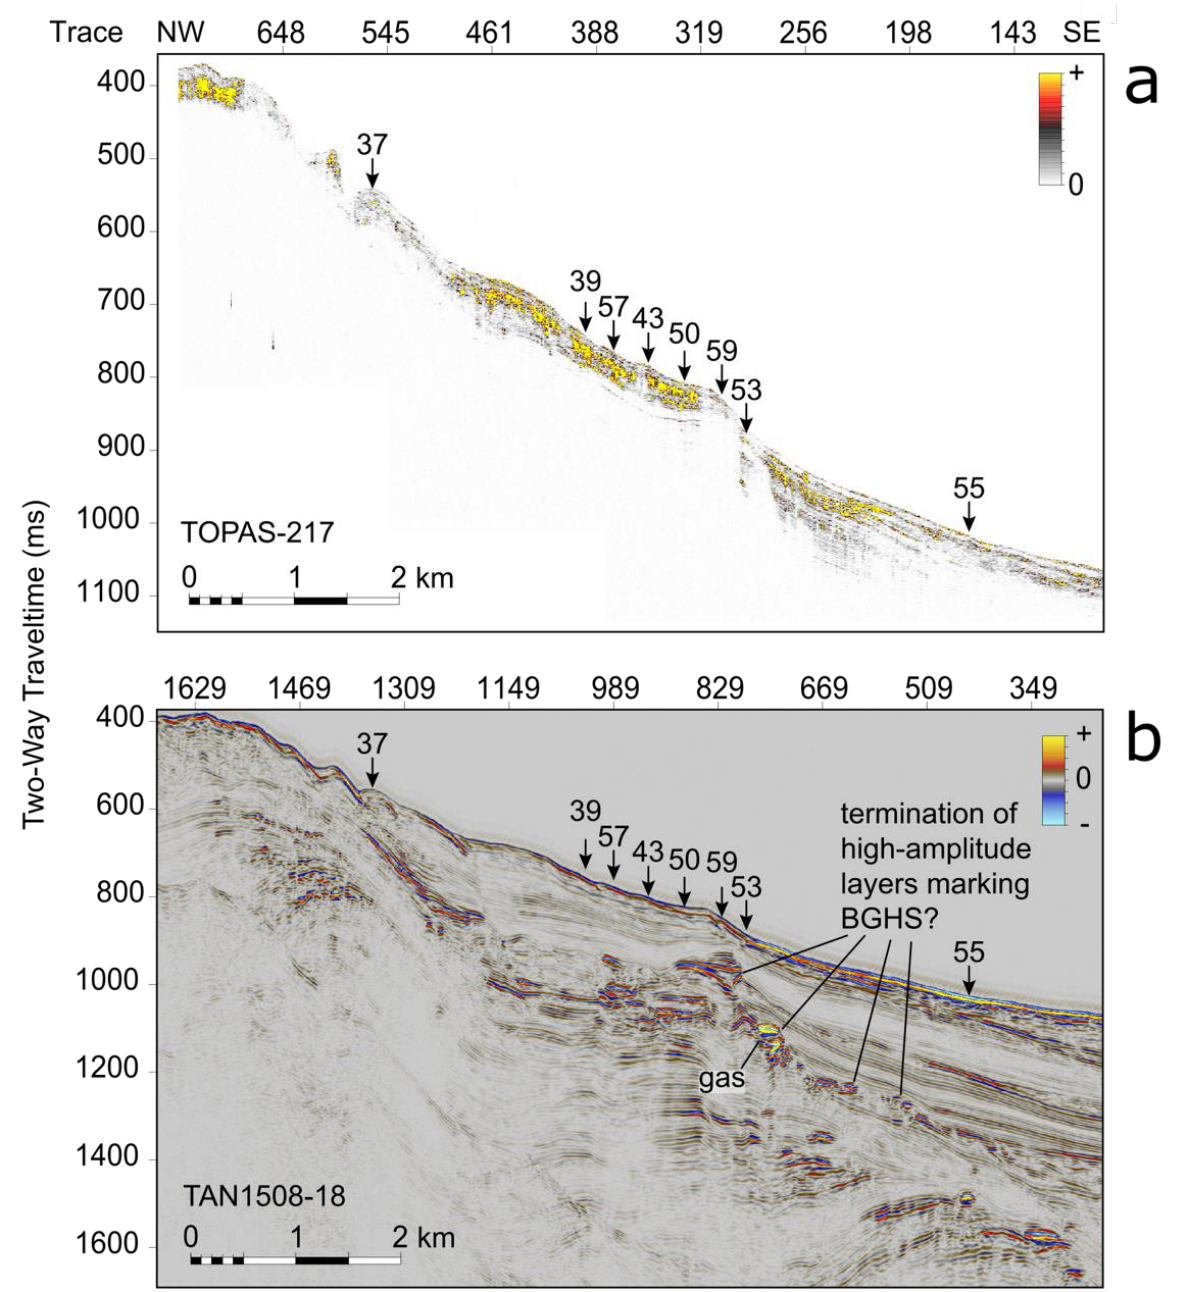
Figure 6. ( a ) TOPAS data from Mahia Transect 2; see Figure 1b for geographical location. Numbered black arrows are piston core sites. ( b ) Seismic data from the same location as the TOPAS data in ( a ). Horizontal scale is the same as for the above TOPAS data plot in ( a ), while the vertical scale differs. The possible base of gas hydrate stability (BGHS) is interpreted as the upper termination of strong reflectivity.